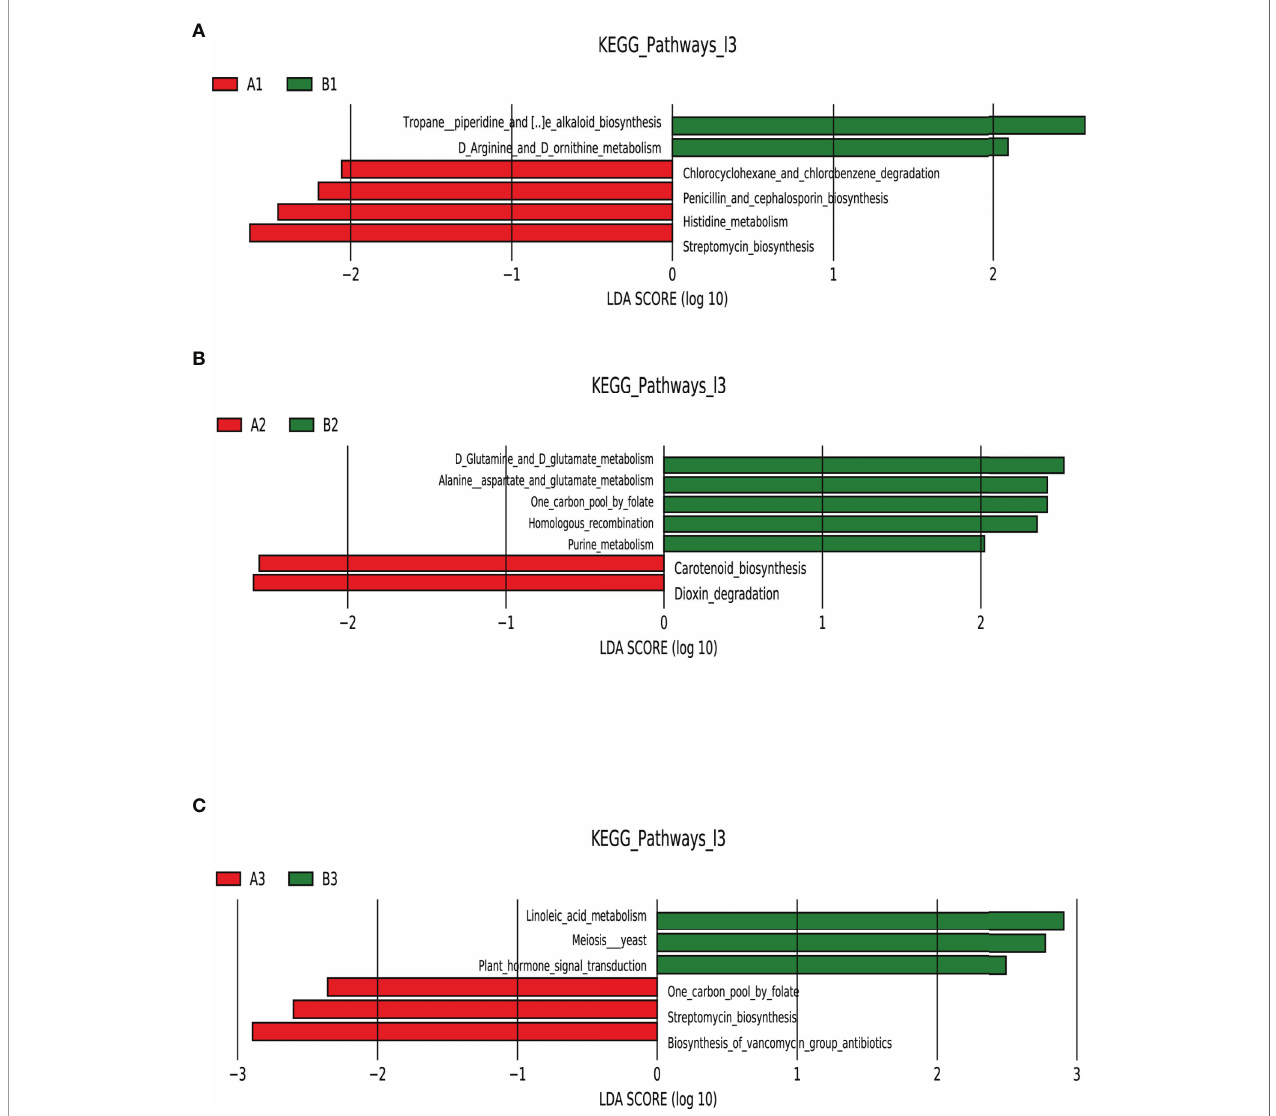
FIGURE 5 | Functional pro fi ling performed with PICRUSt2. LEfSe analysis of differential functional abundance based on the KEGG pathway map. (A) TPOAb-positive vs. TPOAb-negative women with SCH and no LT 4 ; (B) TPOAb-positive vs. TPOAb-negative women with SCH and low-dose LT 4 ; (C) TPOAb-positive vs. TPOAb-negative women with SCH and high-dose LT 4 . LDA value distribution histogram: the red and green bars represented metabolic functions with higher abundance. A1, TPOAb- positive women with SCH and no LT 4 ; A2, TPOAb-positive women with SCH and low-dose LT 4 ; A3, TPOAb-positive women with SCH and high-dose LT 4 ; B1, TPOAb- negative women with SCH and no LT 4 ; B2, TPOAb-negative women with SCH and low-dose LT 4 ; B3, TPOAb-negative women with SCH and high-dose LT 4